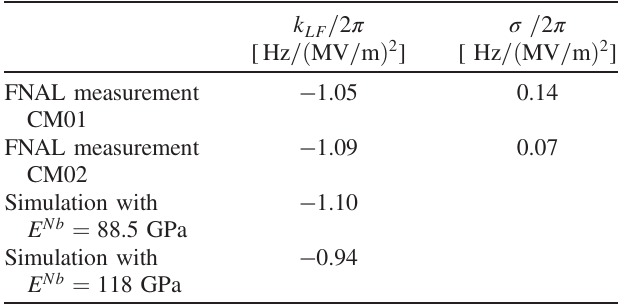
TABLE II. Lorentz force detuning coefficients (mean values and standard deviation, σ ) as measured at FNAL for the eight cavities in cryomodules CM01 and CM02, and simulated with ACE 3 P assuming two values for the Young ’ s modulus of niobium, E Nb